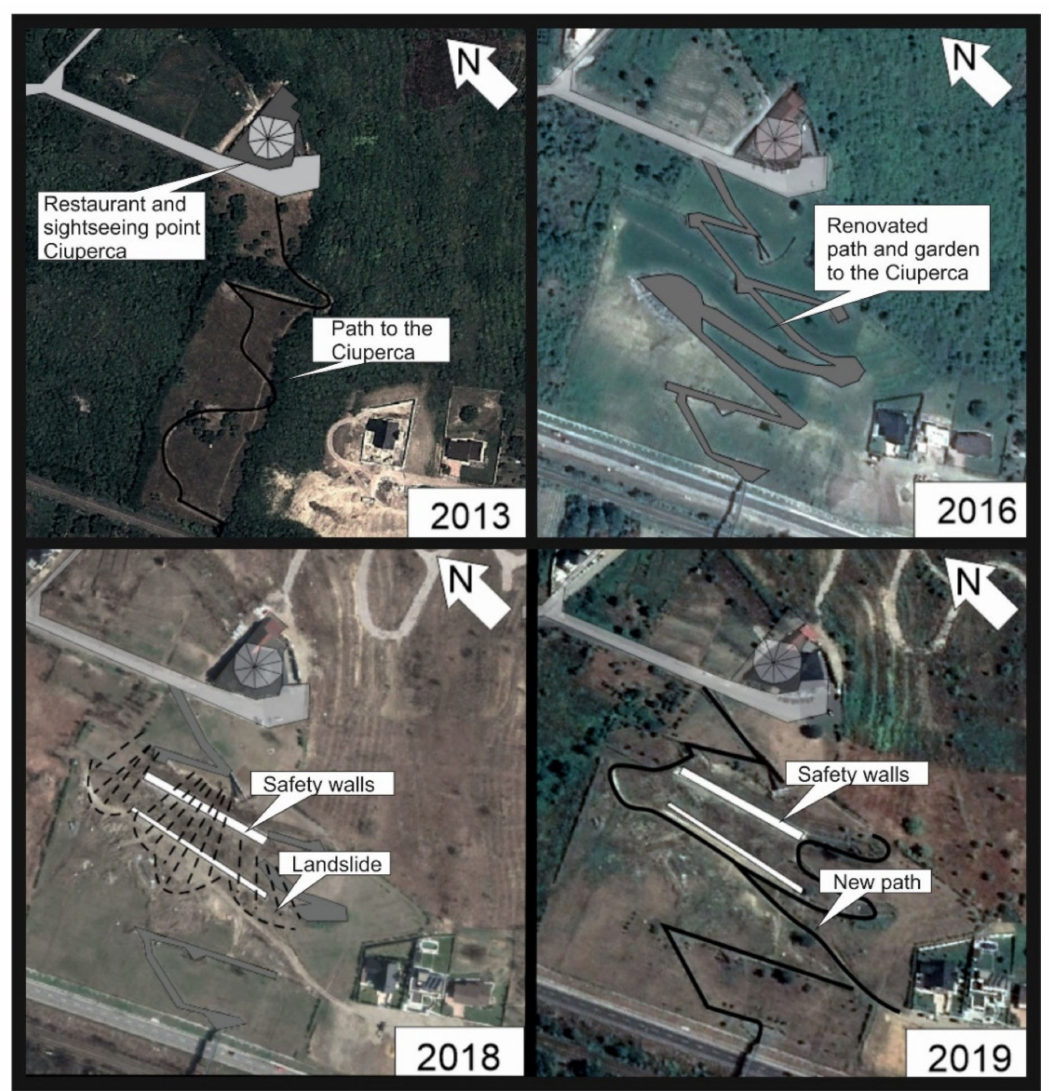
Figure 6. The evolution of the Ciuperca Hill landslide. Data source: modified after